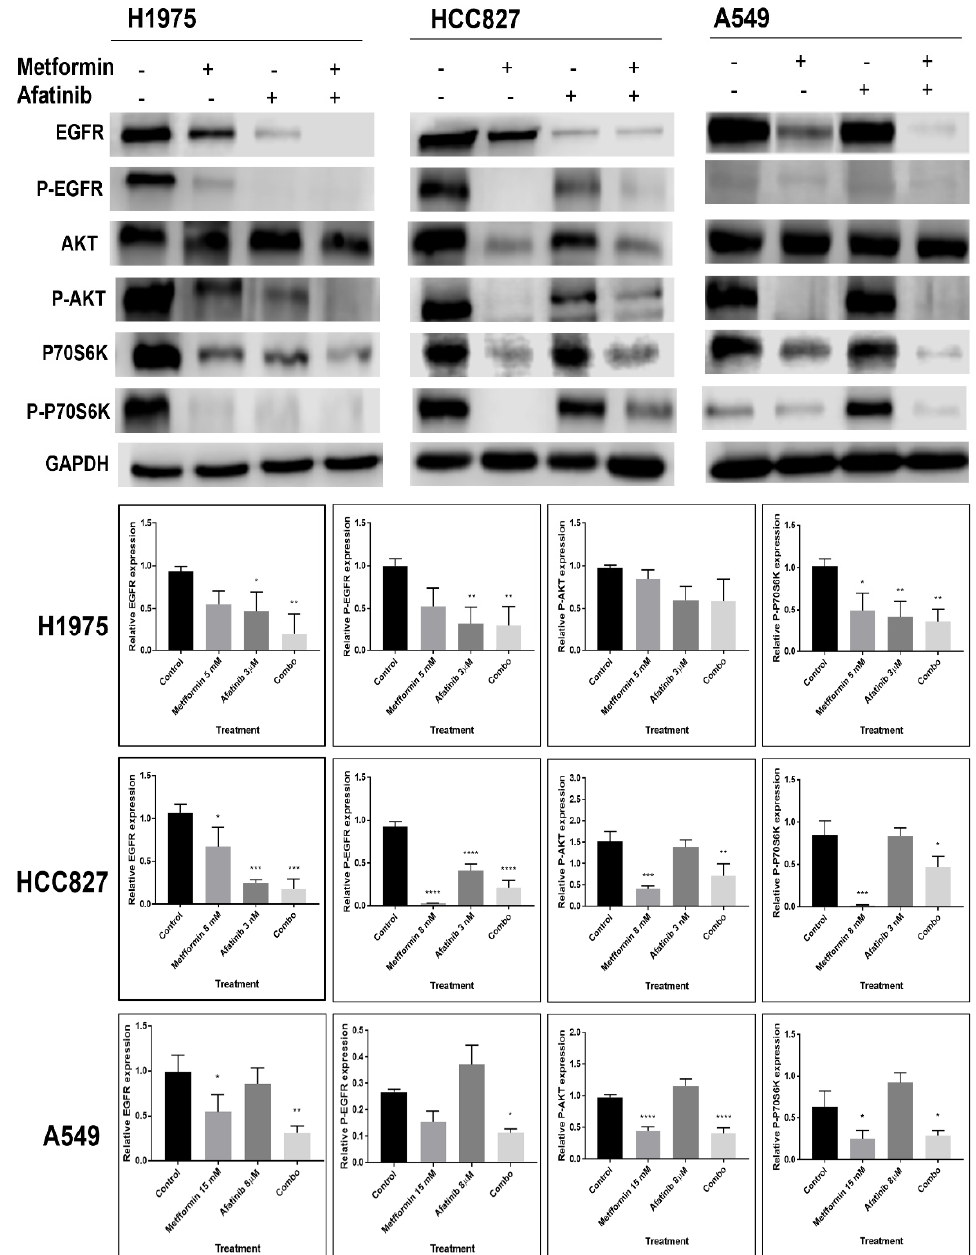
Figure 4. Effect of combination therapy metformin–afatinib on the EGFR signaling pathway. Cells were seeded and treated for 72 h with their respective metformin–afatinib concentrations. GAPDH was used as constitutive control, Western blot images were analyzed by image (NIH) and represented as bars. Images are representative of three independent experiments and results of area are presented as mean ± SD. Data were normalized regarding endogenous control and statistically analyzed by one-way ANOVA. * p ≤ 0.05, ** p ≤ 0.01, *** p ≤ 0.001, **** p ≤ 0.0001.